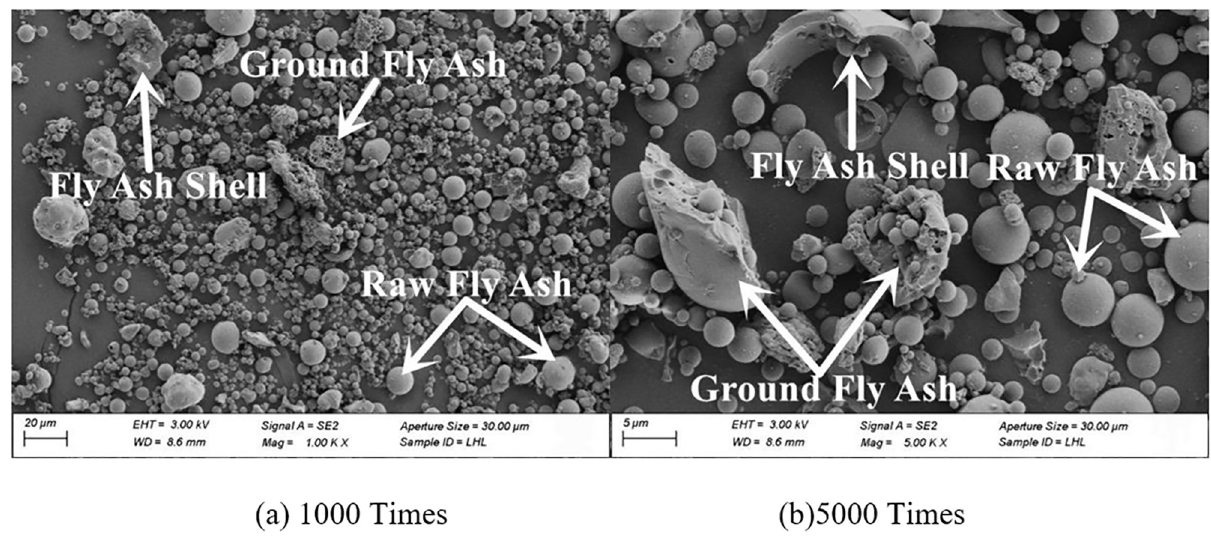
Fig 9. Fly ash microstructure in grinding for 40